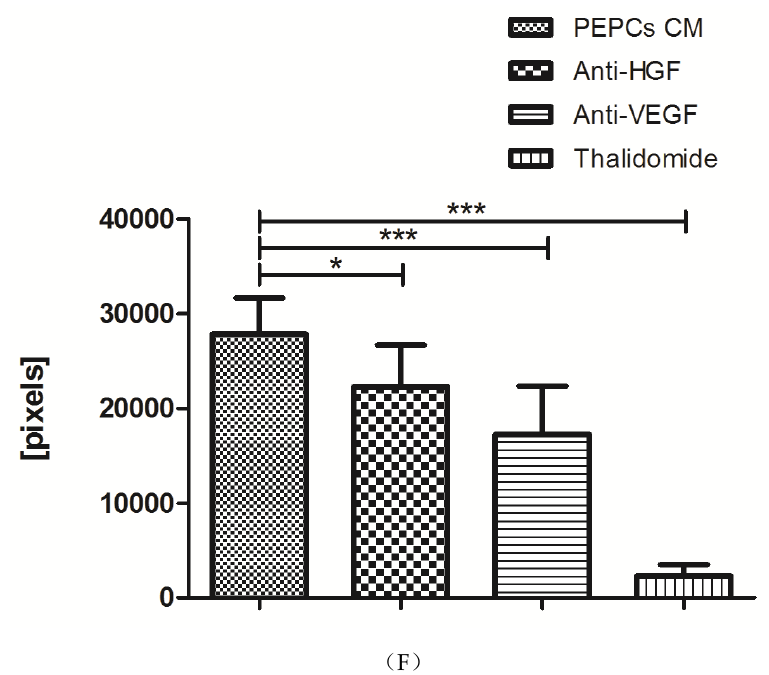
Figure 3. PEPCs conditioned medium enhanced angiogenesis in vitro. ( A ) Twenty thousand HUVEC cells were seeded on a 96-well plate pre-coated with basement membrane matrix. Cells were imaged after 18 hours with a digital camera coupled to a microscope. HUVEC cells cultured in serum-free medium showed no tube formation. ( B ) Few vascular networks formed in serum-free conditioned medium from fibroblasts. ( C ) Well-formed vascular networks developed in cells cultured in PEPCs conditioned medium. ( D ) Cells cultured in completed medium (positive control) showed vascular networks as in PEPCs conditioned medium. ( E ) The total vessel length in pixels under different conditions. Data were pooled from three independent experiments expressed as average ± SD. ( F ) The enhancement was inhibited by anti-HGF, anti-VEGF and thalidomide (* p < 0.05; *** p < 0.001).